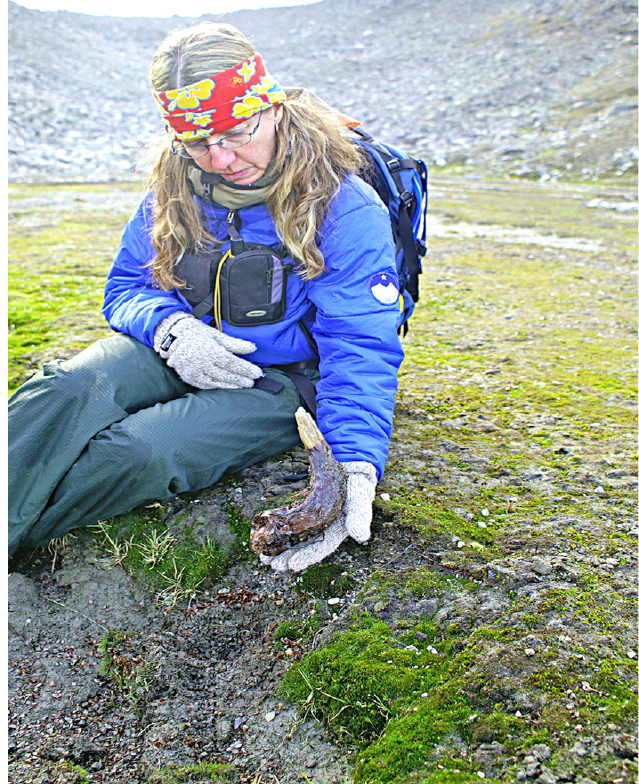
view.Figure 28: Ekorrglaciären (5). A piece of pine wood expo- sed in the lower part of the forefield and clearly not in situ. 9530 cal. yr BP